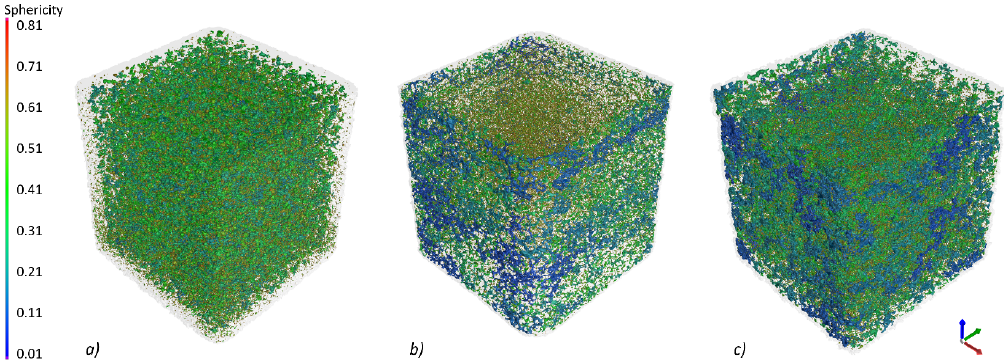
Figure 12. 3D pores visualisation: ( a ) PA2000 ZX (Formiga P110), ( b ) PA12 Smooth ZX (Lisa), ( c ) PA12 Black ZX (S1).